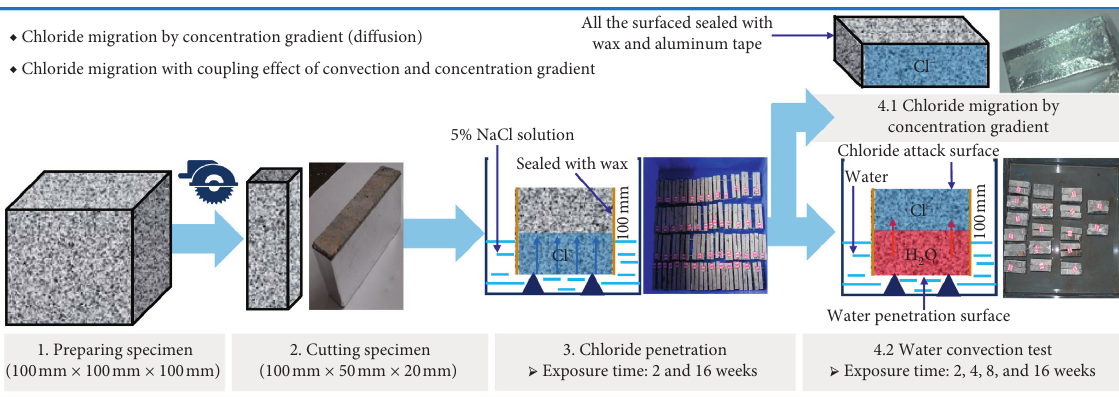
Figure 3: Experiment flow for chloride penetration with coupling of water